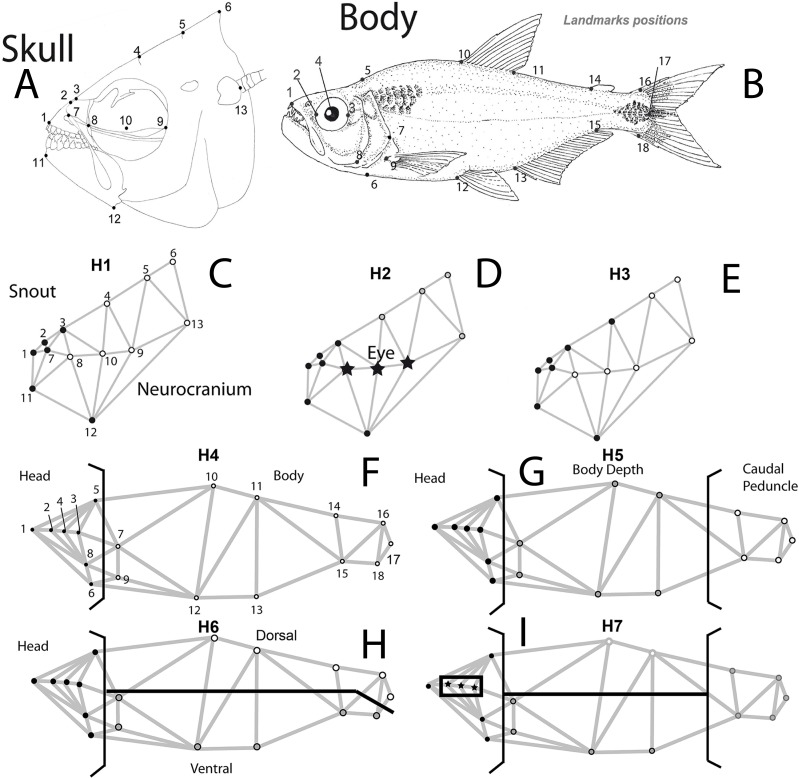
Body and skull landmark positions.Hypotheses of modularity for both data sets: (A) Skull landmarks positions and (B) body shape landmarks positions. (C) Hypothesis 1 (H1), snout or preorbital region (black dots) + the remainder of the skull (white dots), (D) Hypothesis 2 (H2), preorbital region (black dots) + eye (stars) + the remainder of the skull, (E) Hypothesis 3 (H3), snout (extended to include the suture between frontal and parietal bones) (black dots) + the remainder of the skull (white dots), (F) Hypothesis 4 (H4), head (black dots) + body (white dots), (G) Hypothesis 5 (H5), head (black dots) + central body (gray dots) + caudal peduncle (white dots), (H) Hypothesis 6 (H6), head (black dots) + dorsal (white dots) + ventral portions of the remainder of the remainder of the body (gray dots), (I) Hypothesis 7 (H7), eye (stars) + the remainder of the head (black dots) + dorsal and ventral portions of the central body and caudal peduncle (white and gray dots).